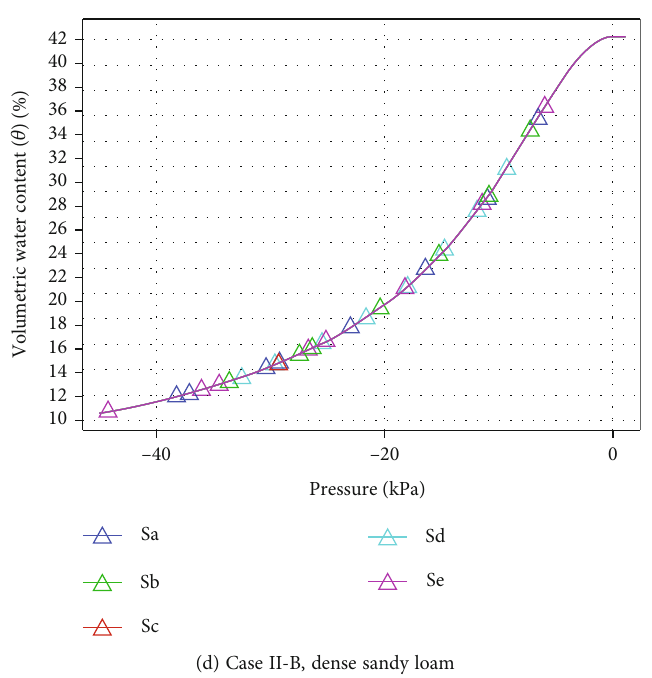
Figure 8: Soil-water characteristic curves (SWCCs) of study cases at irrigation rate of 1 m/s. Time = 150 min Slice: effective saturation ( Θ ) (1)